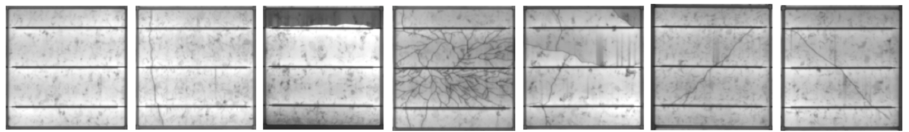
Figure 12. Classification of crack directions. Types of cracks from left to right: No crack, perpendicu- lar crack, parallel crack, dendritic crack, multiple directional cracks, + 45 ◦ cracks and − 45 ◦